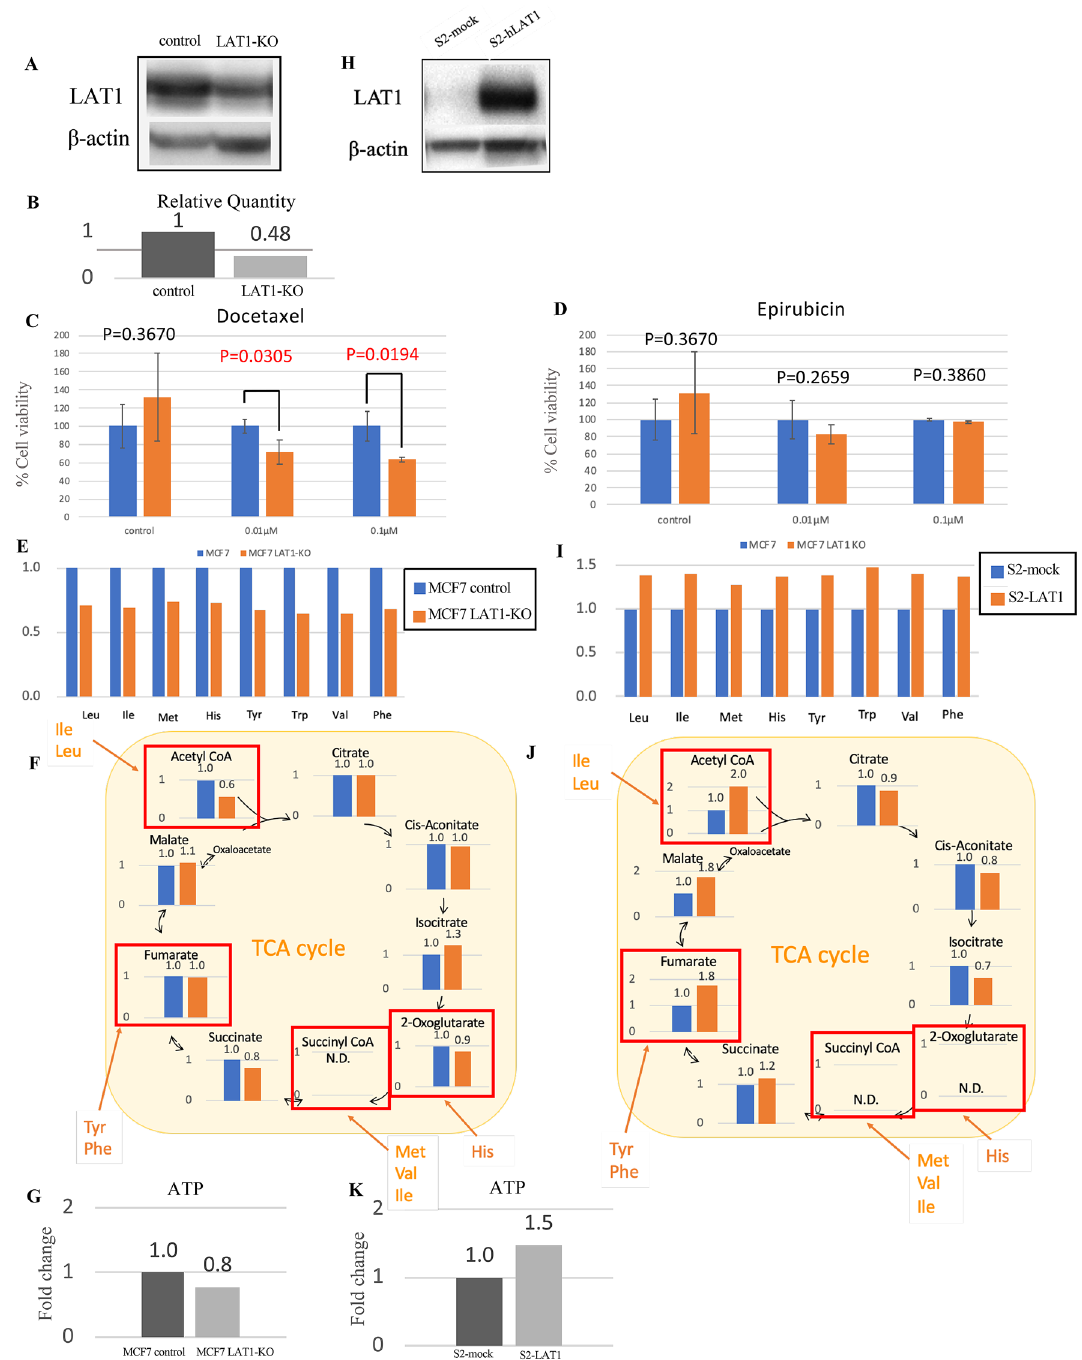
Figure 2. In vitro, MCF7 LAT1 knockout cell and these relative quantity ( A,B ). Cell proliferation in MCF7 control or LAT1-KO cell with 0, 0.01, 0.1 μM docetaxel ( C ) or epirubicin ( D ) for 48 h. Metabolome analysis of control and LAT1-KO cells. These are amino acid levels uptake via LAT1 with control set to 1( E ), intermediates of TCA cycle (fold change) ( F ) and ATP levels (fold change) ( G ). Western blot data of LAT1 protein in S2-mock and S2-LAT1( H ). Metabolome analysis of S2-mock and S2-LAT1 cells. These are amino acid levels uptake via LAT1 with control set to 1( I ), intermediates of TCA cycle (fold change)( J ) and ATP levels (fold change) ( K